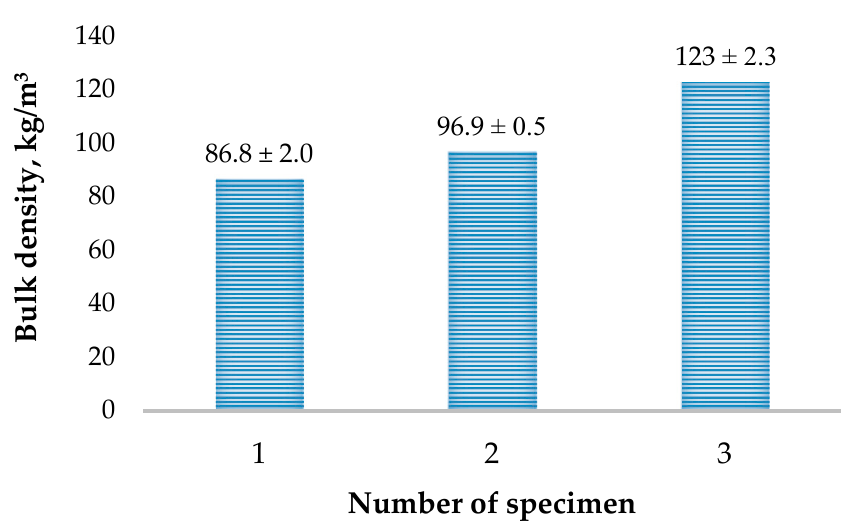
Figure 5. Results of the bulk density of wood waste, when fraction, mm: 1—0/20; 2—0/10 and 3—